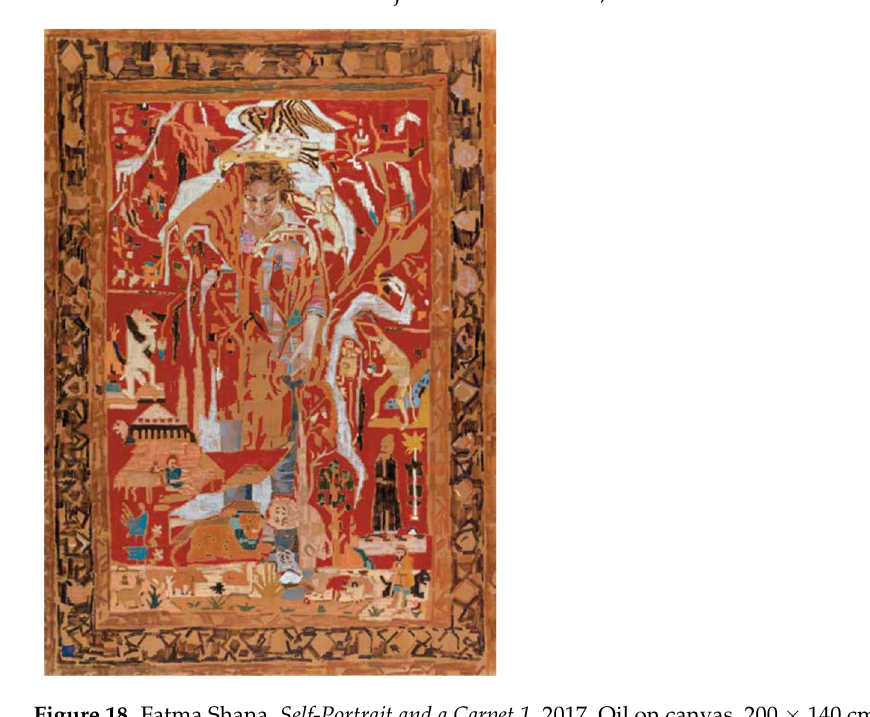
Figure 18. Fatma Shana, Self-Portrait and a Carpet 1 , 2017, Oil on canvas, 200 × 140 cm.